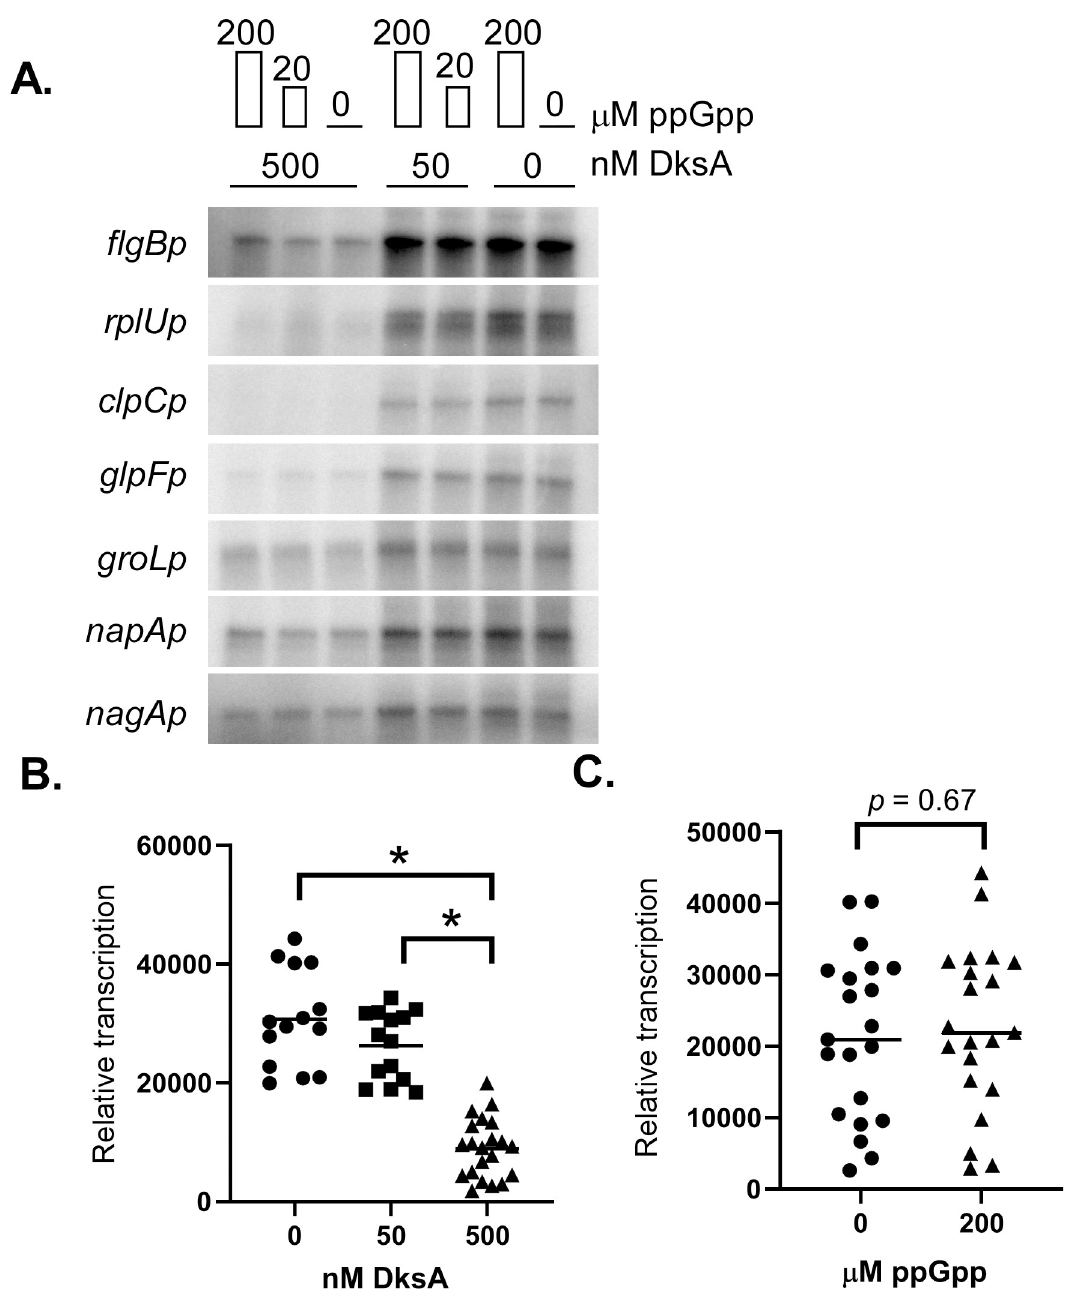
Fig 2. In vitro transcription reactions to assay ppGpp and DksA effects on transcription initiation from seven B . burgdorferi promoters. In vitro transcription reactions initiated on seven RpoD-dependent promoters were prepared containing 500, 50, or 0 nM DksA and 200, 20, or 0 μ M of ppGpp. (A) RNA was separated by gel electrophoresis on a 10% urea gel are shown. First, fourth, and sixth lanes contained 200 μ M of ppGpp. The second and fifth lanes contained 20 μ M ppGpp. Phosphor screen signals from all in vitro transcription reactions were pooled to evaluate (B) DksA-dependent effects on transcription using a non-parametric ranked Kruskal–Wallis multiple comparisons test and (C) ppGpp-dependent effects using non-parametric ranked Mann-Whitney comparison test. Asterisk indicates p-value < 0.001 in multiple comparison